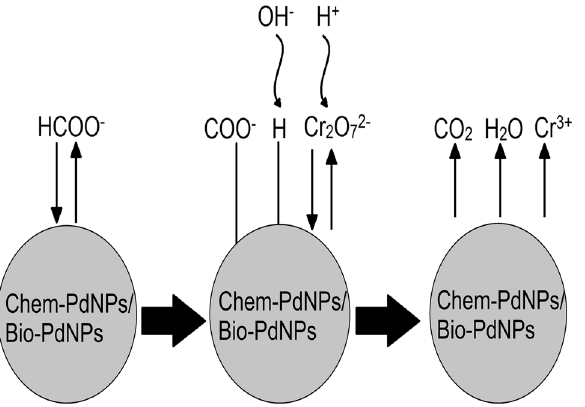
Figure 7. Schematic for the reduction of Cr(VI) using the Langmuir–Hinshelwood kinetics. The surface of the Chem-PdNPs and Bio-PdNPs is where the reaction is taking place. Formate (HCOO − ) is adsorbed on the surface and forms adsorbed H (ads) and COO − (ads) intermediates according to Eq. (1). The intermediates donate electrons according to Eqs. (2) and (3) to the adsorbed dichromate (Cr 2 O 72− ) in the presence of hydrogen ions and hydroxide ions. Upon acceptance of electrons, Cr 2 O 7 2− reduces to Cr 3+ according to Eq. (4) and the products desorb from the surface to start a new catalytic